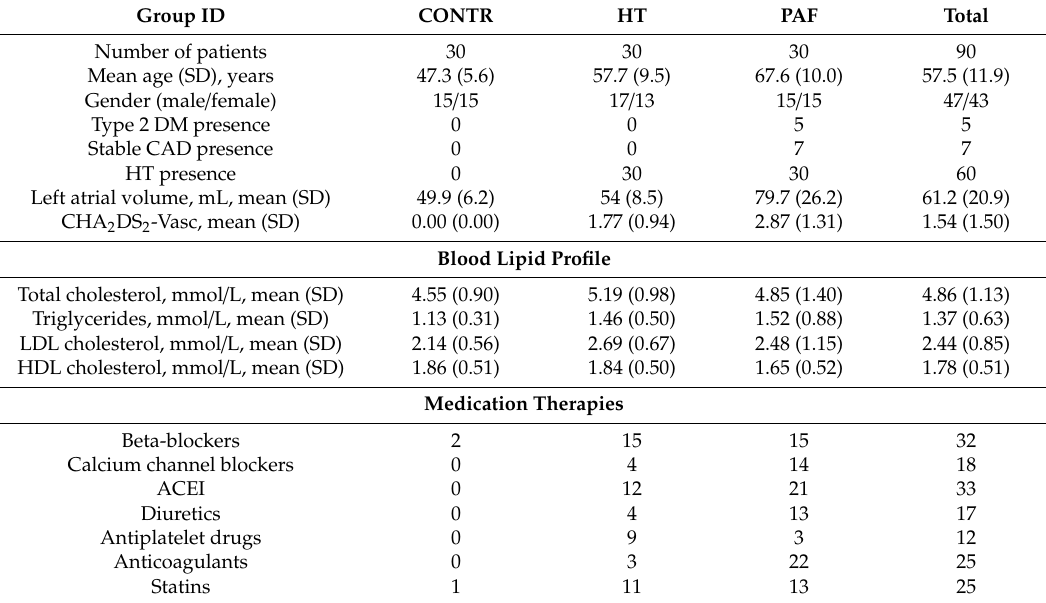
Table 1. Characteristics of the study sample groups: PAF: 30 paroxysmal atrial fibrillation (PAF) patients; HT: 30 hypertensive patients without atrial fibrillation (AF); CONTR: 30 healthy controls. SD: standard deviation; ACEI: angiotensin-converting enzyme inhibitors. Group